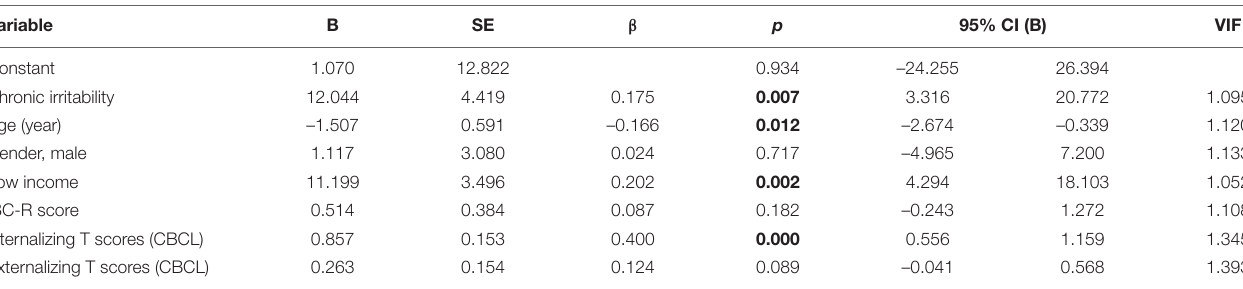
TABLE 4 | Results of multiple regression analysis showing predictors of SSP total scores in the chronic irritability